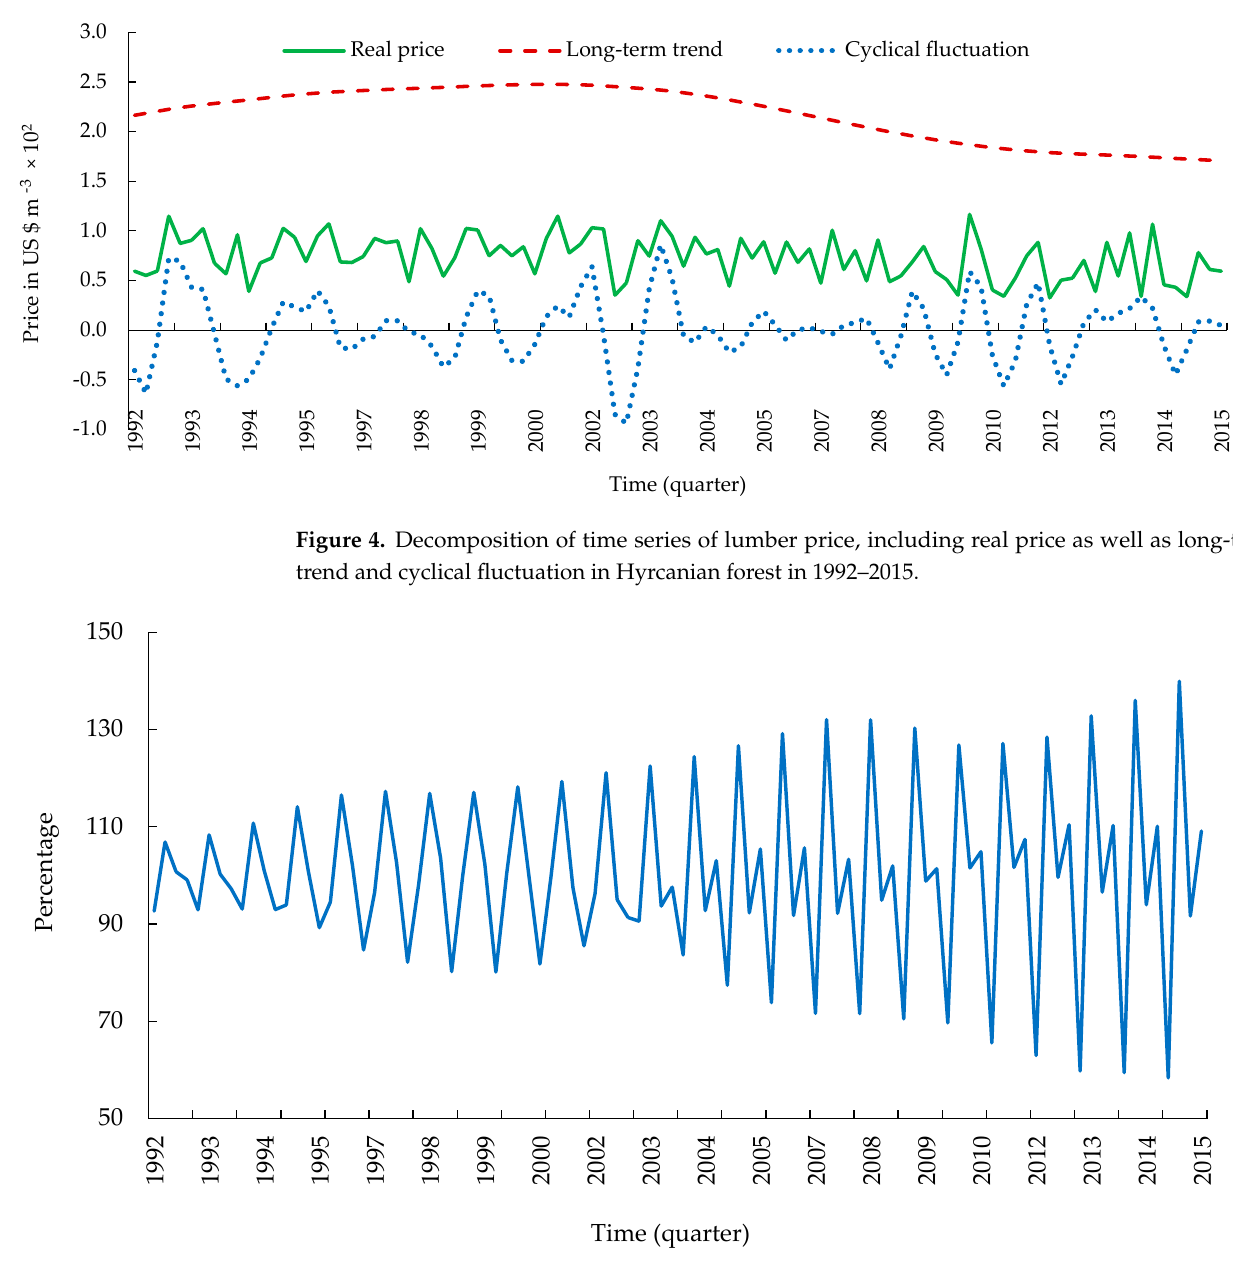
Figure 5. Decomposition of time series of lumber price, including seasonal fluctuation indices in Hyrcanian forest in